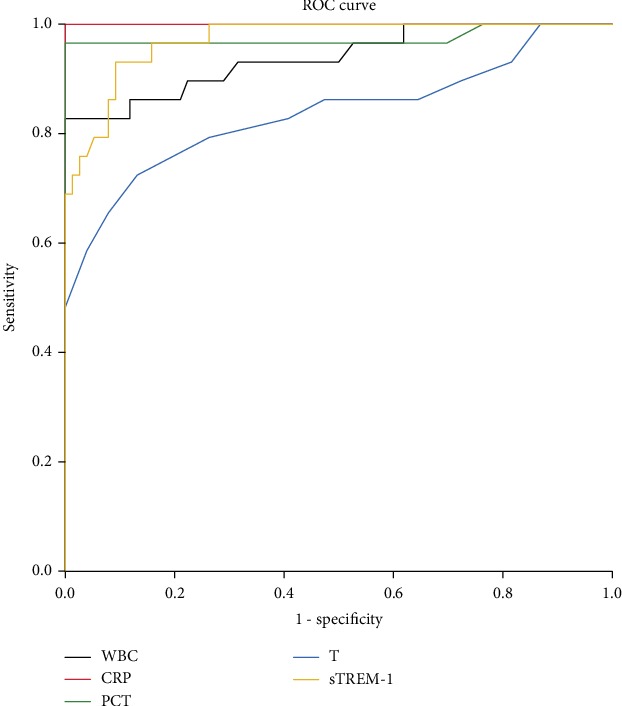
ROC curves of WBC, CRP, PCT, sTREM-1, PCT, and T between Group A and Group C. WBC (black): white blood cell; CRP (red): C-reactive protein; PCT (green): procalcitonin; sTREM-1 (yellow): soluble triggering receptor expressed on myeloid cells 1; T (blue): temperature. Group A: AC patients with sepsis; Group C: inpatients without AC or other infections.